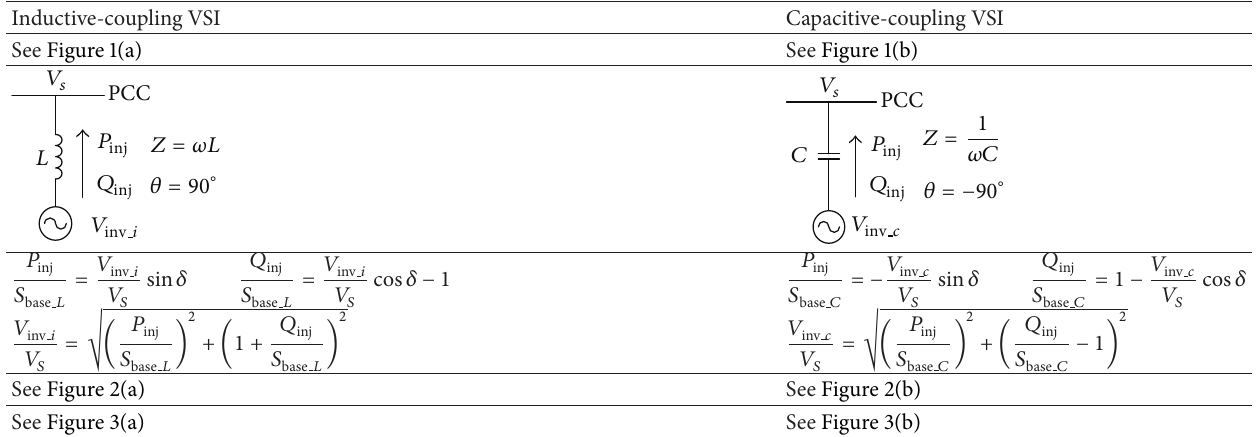
Table 1: Comparisons for fundamental frequency power flow control.